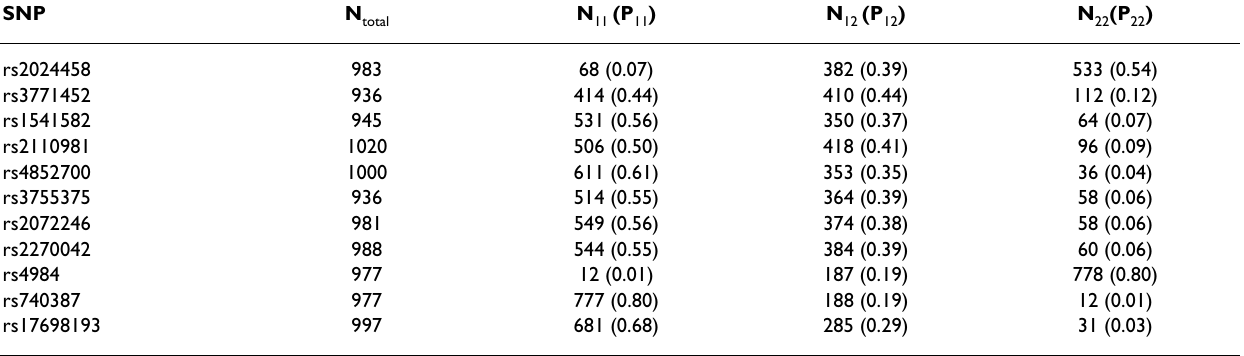
Table 2: SNP sample size information SNP N